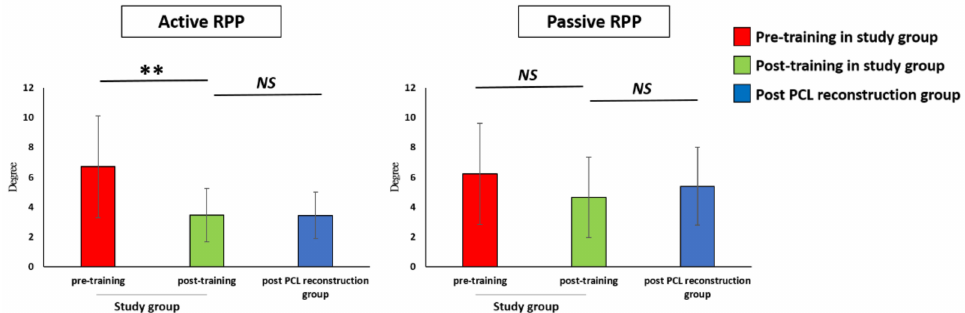
Figure 5. Comparison of proprioception change at pre-training, at post-training, and in the post-PCL reconstruction group. RPP: Reproduction of passive position test. PCL: Posterior cruciate ligament. ** p < 0.01 indicates high statistical significance between two groups. NS: No significant difference between two